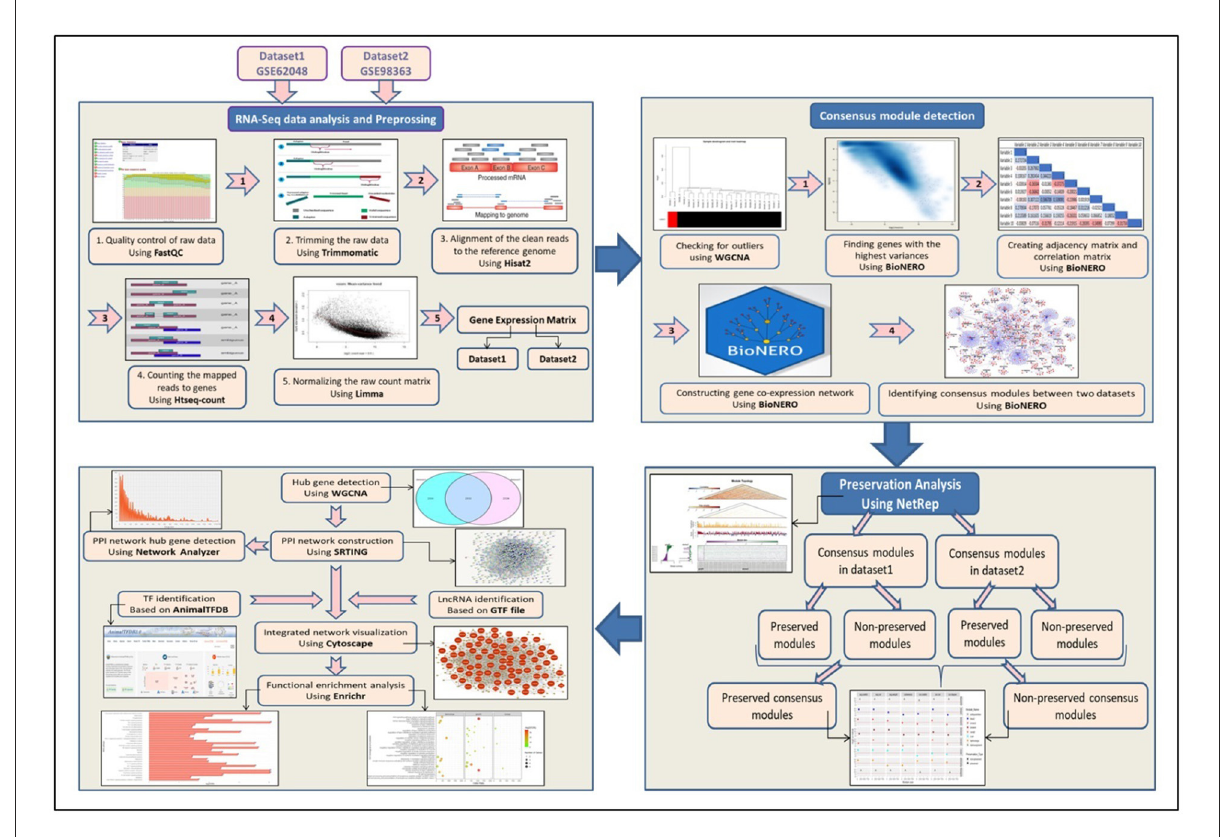
FIGURE1 The flow chart of the methodology used in the present